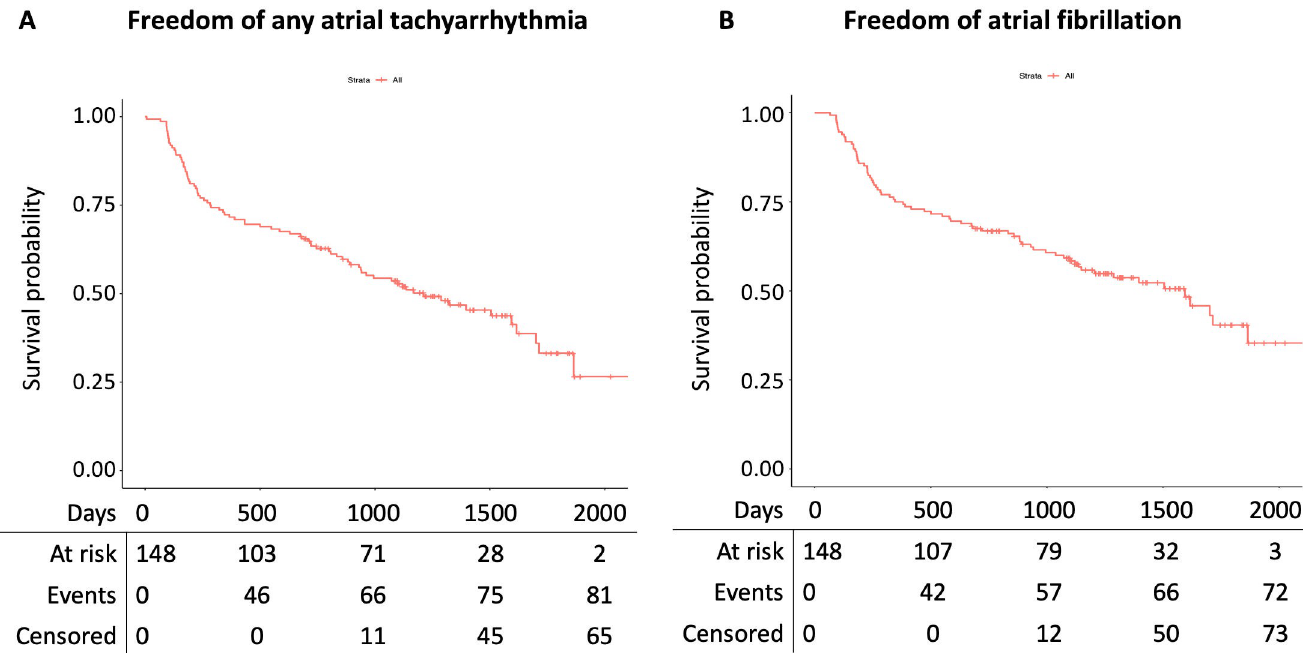
Fig 2. Arrhythmia free survival analyses. A. Survival analysis of freedom of any atrial arrhythmia. B. Survival analysis of freedom of atrial fibrillation.